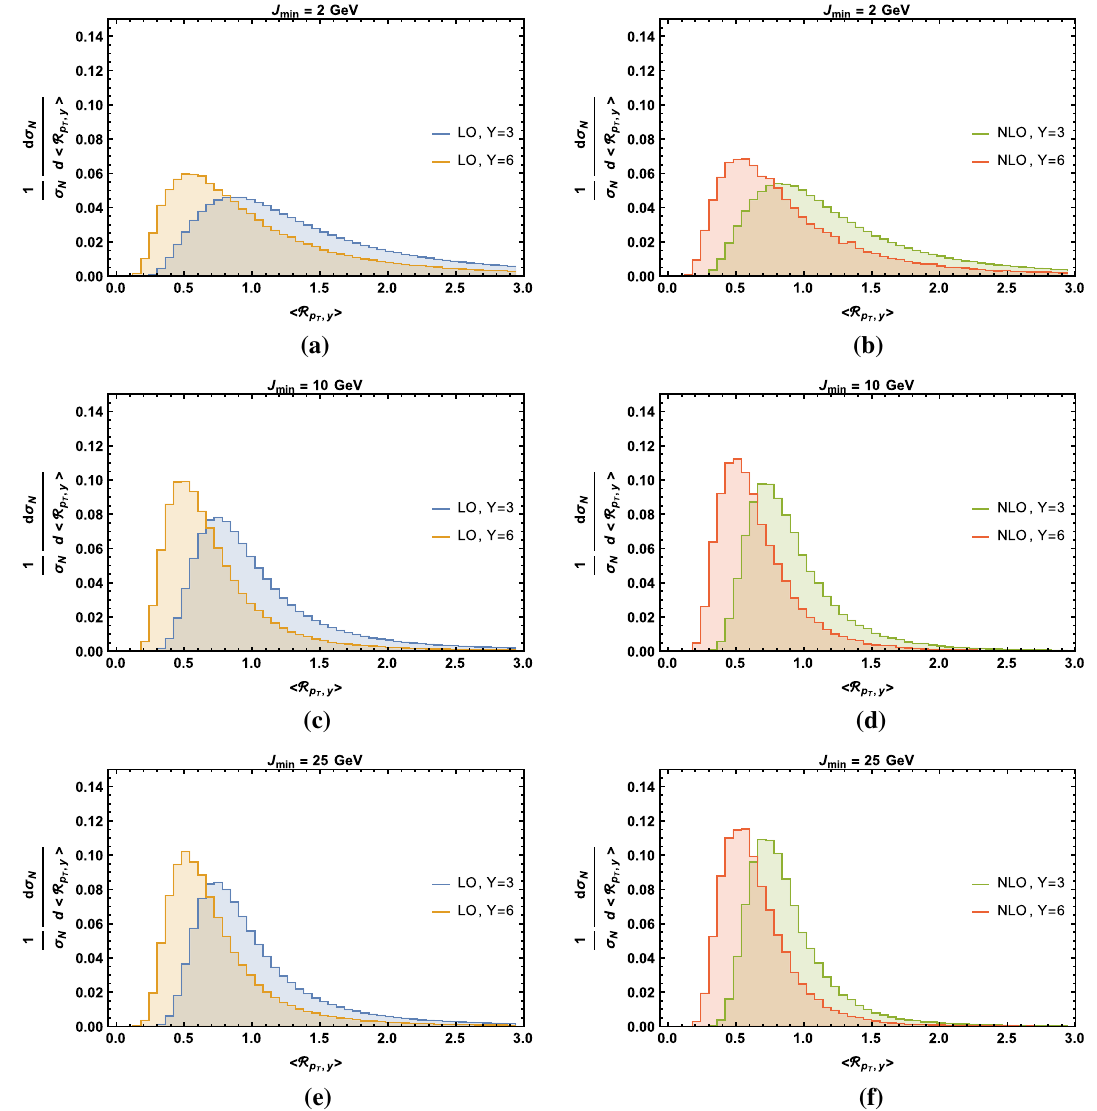
(cid:11) at LO (left) and NLO+DLs (right) for multiplicity N = 5, rapidity difference Y = 3 , 6 and J Fig. 7 Normalized (cid:10) R p T , y (middle), J min = 25 (bottom) bottom have J min = 25 GeV. In all cases, the values of (cid:10) R y (cid:11) are bounded by 0 and